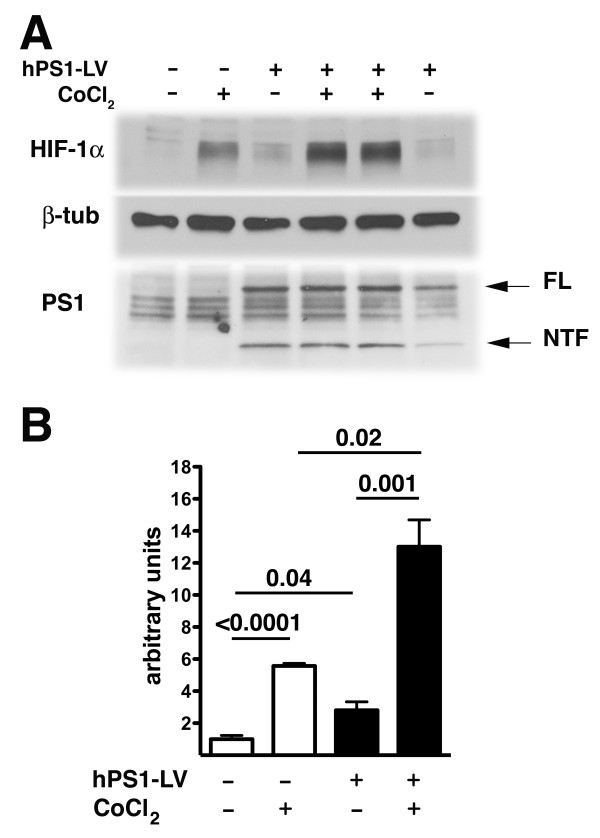
Reintroduction of Psen1 into Psen1-/- fibroblasts. Psen1-/- fibroblasts were infected with lentiviruses carrying the human Psen1 cDNA (hPS1-LV) for 24 hours and grown in complete medium for 48 hours. The infected cells were then treated for 4 hours with 100 μM cobalt chloride along with non-infected Psen1-/- cells grown in parallel. The cells were lysed and analyzed for HIF-1α induction by Western blot using anti HIF-1α polyclonal antibodies. Blots were reprobed for anti β-tubulin as a loading control. Psen1 expression was analyzed using the NT.1 mouse monoclonal antibody. FL: full length, NTF: N-terminal fragment. A representative blot is shown in panel A. Panel B shows quantitation of the HIF-1α response (n = 3 samples per group non-infected; n = 4 infected). P values (unpaired t-tests) are indicated for selected comparisons which are discussed further in the text.